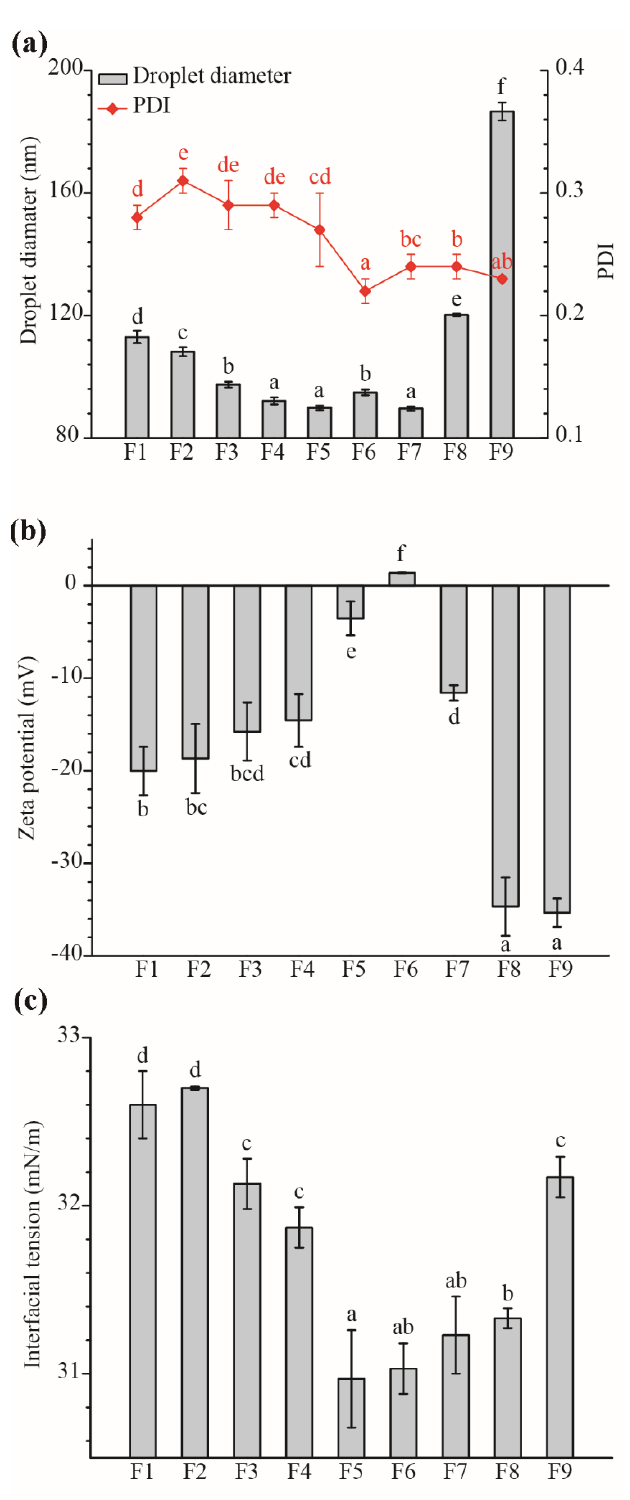
Figure 3. Droplet size ( a ), zeta potential ( b ), and interfacial tension ( c ) of ZBEO nanoemulsions with different ratio of Tween 40 with TS. The data represent the mean ± SD ( n = 3). abcdef , means within the same column followed by the same letter are not significantly different ( p > 0.05) in one-way analysis of variance and Duncan’s test.